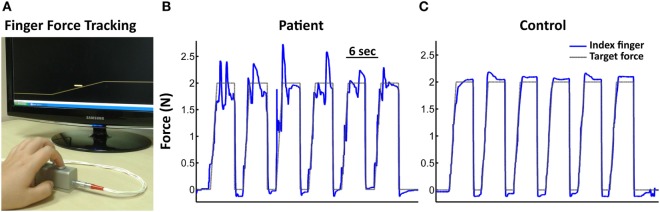
Finger Force Manipulandum (FFM) setup and single subject force-tracking examples. (A) FFM with a screen providing visuomotor feedback during the finger force-tracking task. The yellow line on the screen represents the target force. The cursor (horizontal bar close to the ramp) represents the instantaneous force exerted by the index finger. The subject had to match the vertical cursor position to the right-left scrolling target force. Target force represents a ramp-hold-and-release paradigm. Target forces of 1 N or 2 N hold-level correspond to a typical range employed in daily object manipulation. Subjects performed the task separately with the right index and the middle finger. (B,C) Single subject force-tracking examples of six successive trials at a target force (black trace) of 2 N with the index finger (blue trace). (B) For a patient. (C) For a control subject. Note greater tracking error in the patient.